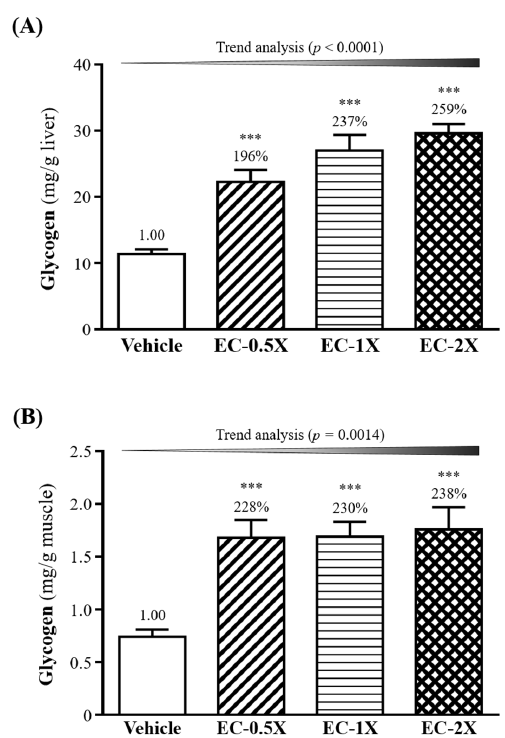
Figure 6. Effect of EC supplementation on glycogen levels in the ( A ) liver and ( B ) muscle. Mice were pretreated with the vehicle, EC-0.5X, EC-1X, and EC-2X for 28 days. Data is expressed as mean ± SEM ( n = 10). Numbers above bars indicate percentage (%) change with vehicle control fixed at 100%. Significant difference from control group according to one-way ANOVA is indicated *** p < 0.001.